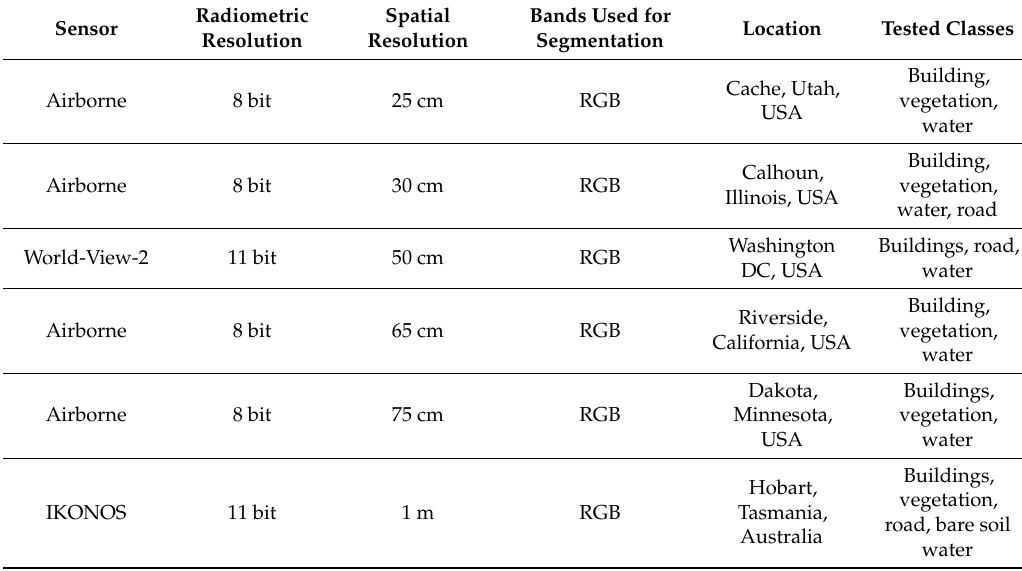
Table 1. Details of the six test images used in this